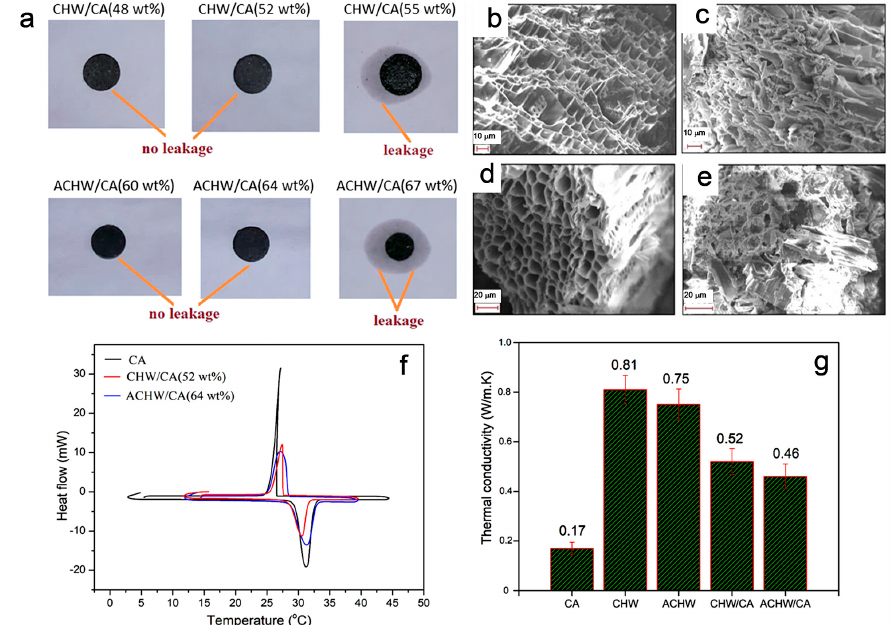
Figure 10. ( a ) Photos of leakage tests of composite PCMs (CHW/CA and ACHW/CA); ( b – e ) SEM microstructures of CHW, seepage-free composites CHW/CA, ACHW/CA; ( f ) DSC thermograms of reference (pure CA) and composites and ( g ) bar graph of thermal conductivity trends of reference CA, CHW, ACHW and leakage-free PCM composites. Abbreviations in the figures are as follows: CA = capric acid, ACHW = activated carbonized hazelnut wood, CHW = carbonized hazelnut wood. Reproduced with permission from reference [54], copyright, 2021, Wiley VCH.